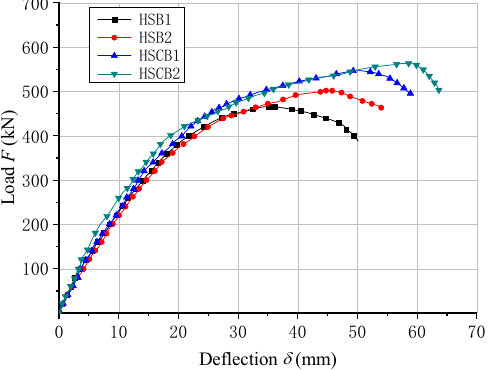
Figure 5. Load-deflection curves of HSS—concrete composite beams.